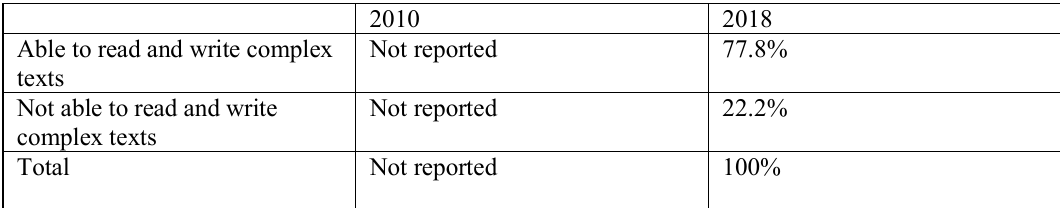
Table 6: Self-assessment by adults with low literacy (alpha levels 1–3) and a first language other than German of their ability to read and write complex texts in their first language.